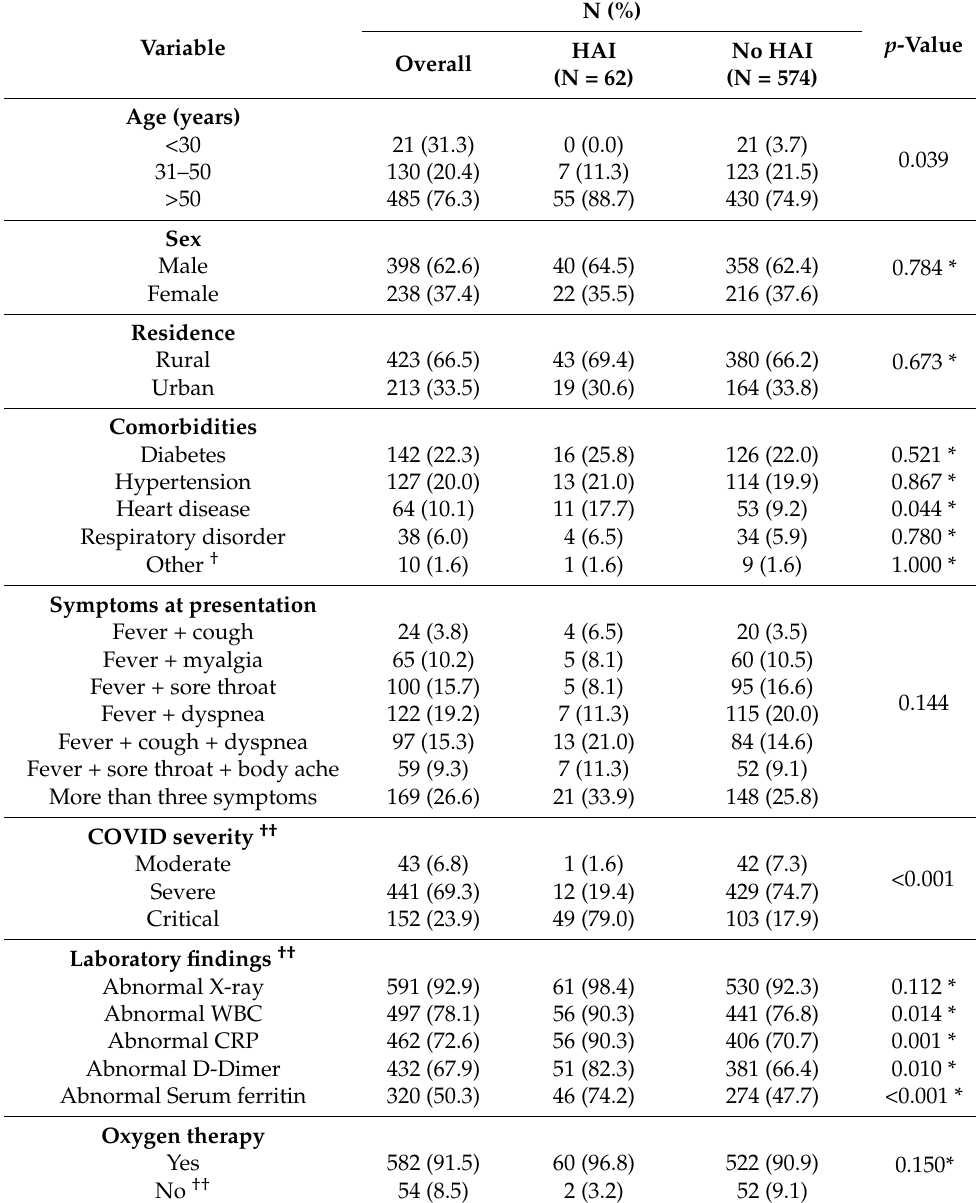
Table 1. Demographics and clinical features of COVID-19 patients with and without healthcare- associated infections